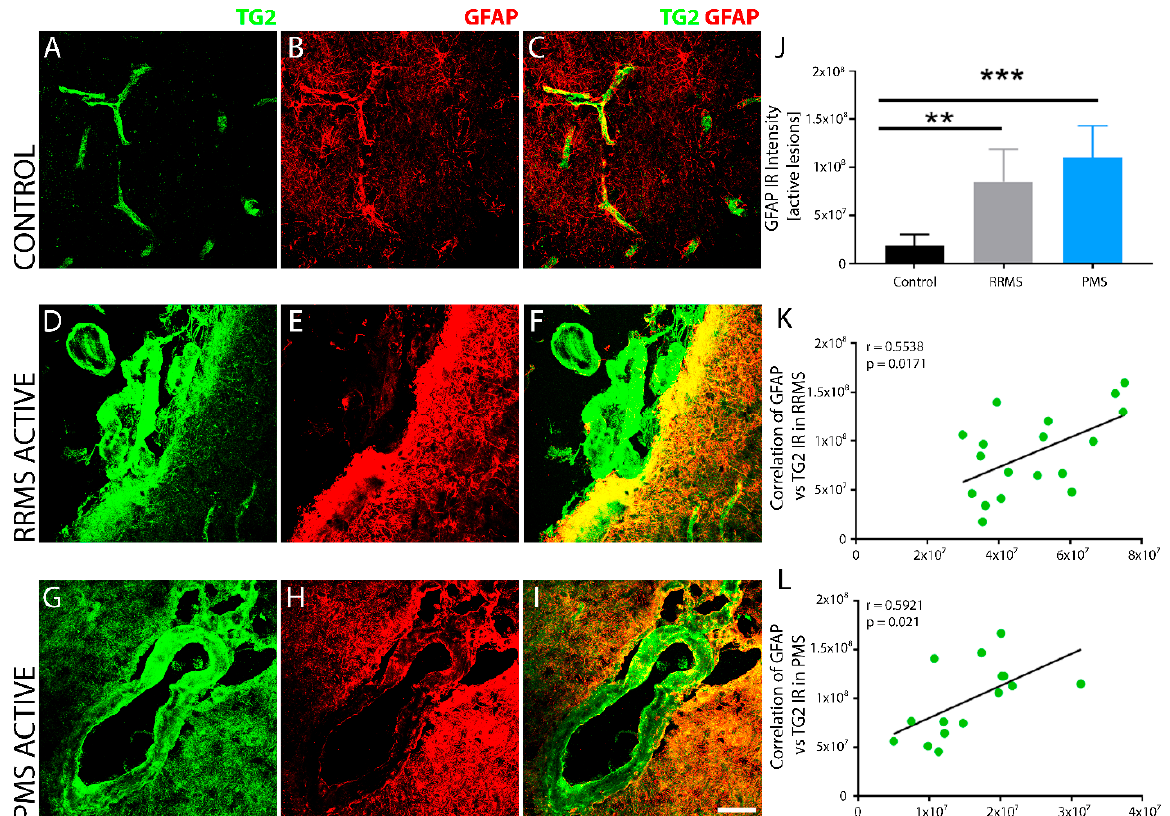
Figure 4. TG2 immunoreactivity is robustly upregulated in endothelial cells within active lesions of MS brain tissue. Compared to non ‐ MS brain tissue (Top panel; A – C and Bottom panel; J – L ), which showed low levels of basal TG2 expression ( A , C , J , L ) in the endothelial cells labelled with CD31 (Top panel, B , E , H ) or tomato lectin (Bottom panel, K , N , Q ), TG2 expression was robustly increased in the active lesions of both forms of MS; RRMS (Top panel D , F and Bottom panel M , O ) and PMS (Top panel, G , I and Bottom panel P , R ).